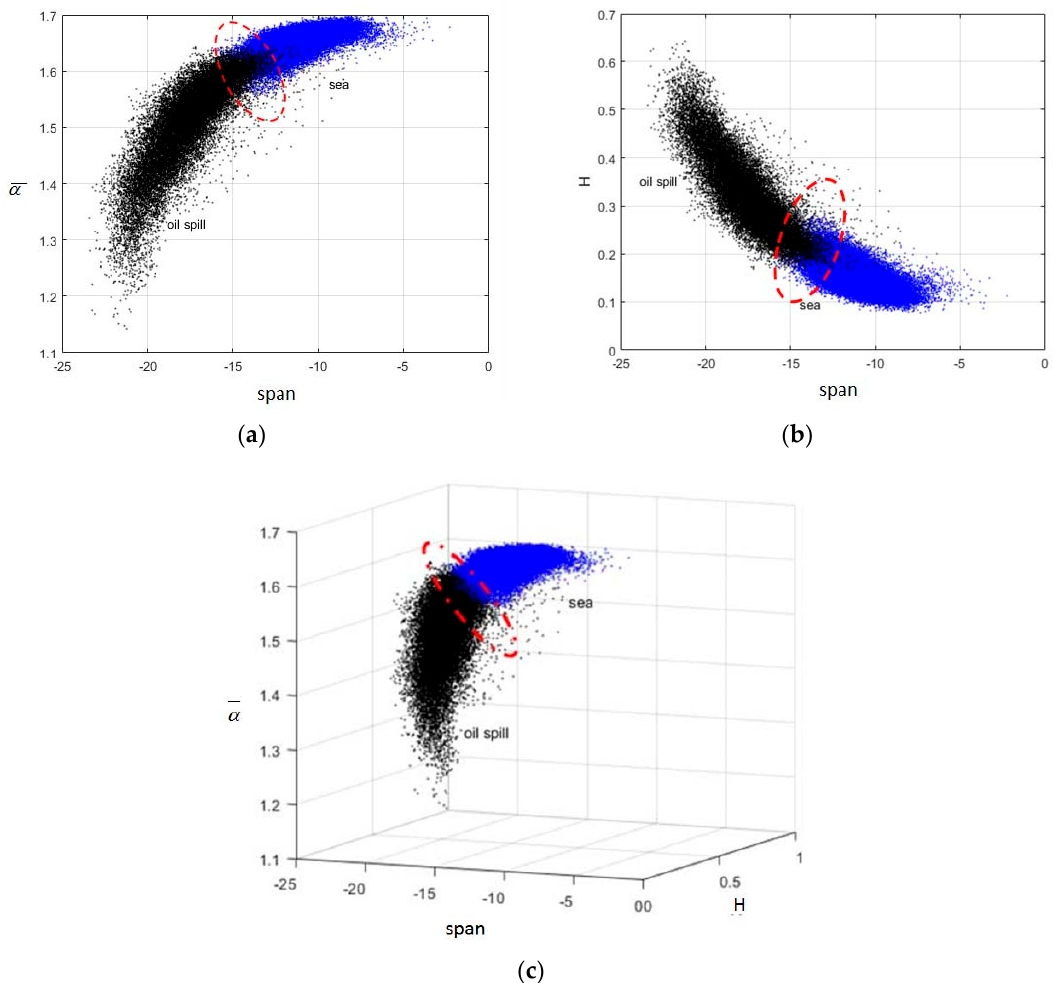
Figure 4. Clusters of ocean oil spill and water in region of interesting in two and three dimensional feature space: ( a ) span -  ; ( b ) span - H ; and ( c )  - span - H . feature space: ( a ) span - α ; ( b ) span - H ; and ( c ) α - span - H